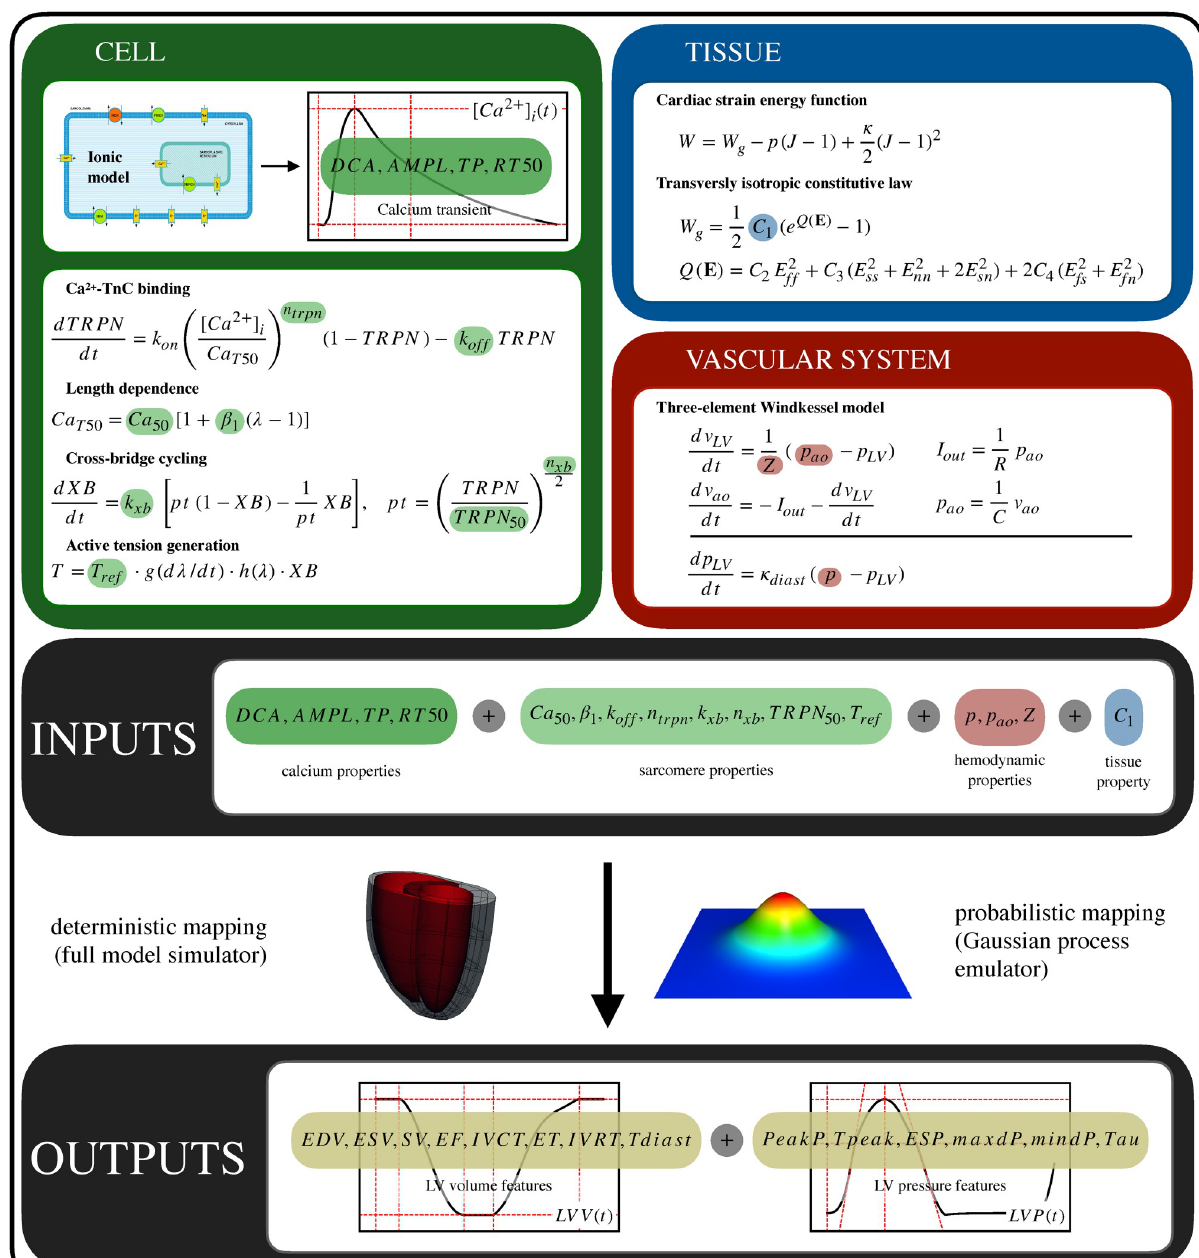
Fig 1. 3D biventricular rat heart contraction model multi-scale map. Chosen 16 input parameters are calcium transient and sarcomere properties (green), hemodynamics properties (red) and tissue properties (blue). The output features of interest are 14 indexes (yellow) characterising the LV function and are extracted from the LV pressure and volume curves. The input parameters (Table 1) can be quantitatively be mapped to the output features (Table 2) either by running the full model or by making predictions using trained